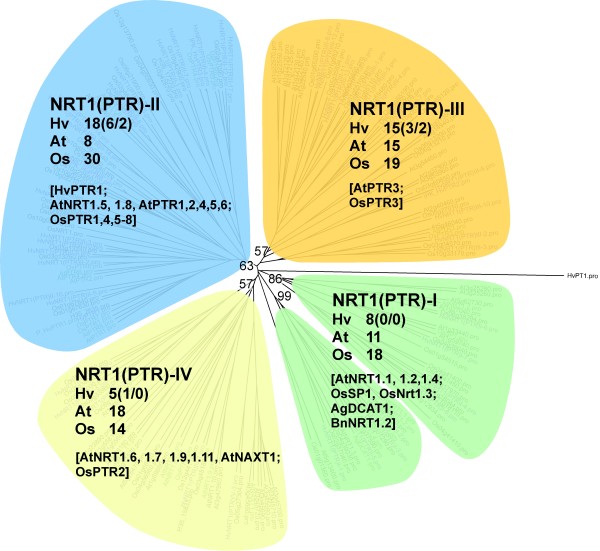
Phylogenetic tree of plant NRT1/PTRs. Clustering of 52 Arabidopsis, 81 rice and 46 unique barley sequences; for consolidation of the tree, sequences from Alnus glutinosa (AgDCAT1) and Brassica napus (BnNRT1) were included (according to Tsay et al. [14]). Colours indicate membership to subgroups I (green), II (blue), III (orange) and IV (yellow) as defined by Tsay et al. [14]. Barley sequences were derived from RNA-seq, H35 (only full-length sequences), publications (HvPTR1) and previous unpublished work (IPK_HvPTR2, 3, 6). Clustering of NRT1/PTR sequences into different subgroups is supported by the sequence distance matrices (Additional file 5: Figure S4). Detailed version of the phylogenetic tree including ID-numbers of all sequences is given in Additional file 4: Figure S3. For further explanations see legend of Figure 6.